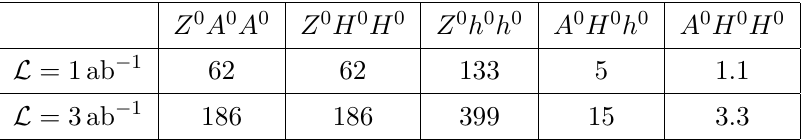
Table 4 . The expected number of events for two benchmark luminosities at m H = 175 GeV and t (cid:12) = 10 are